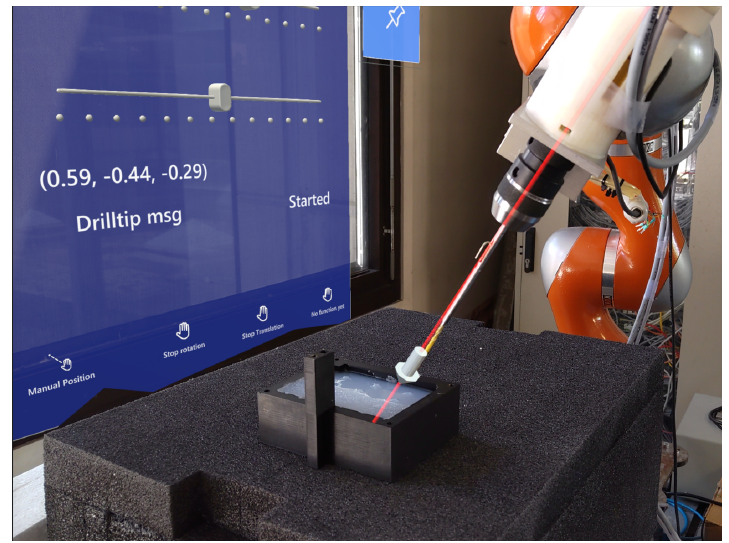
Figure 6. The positioning of the robot using the AR interface. After defining the pose with the AR arrow, the robot was moved using the GUI and aligned with the